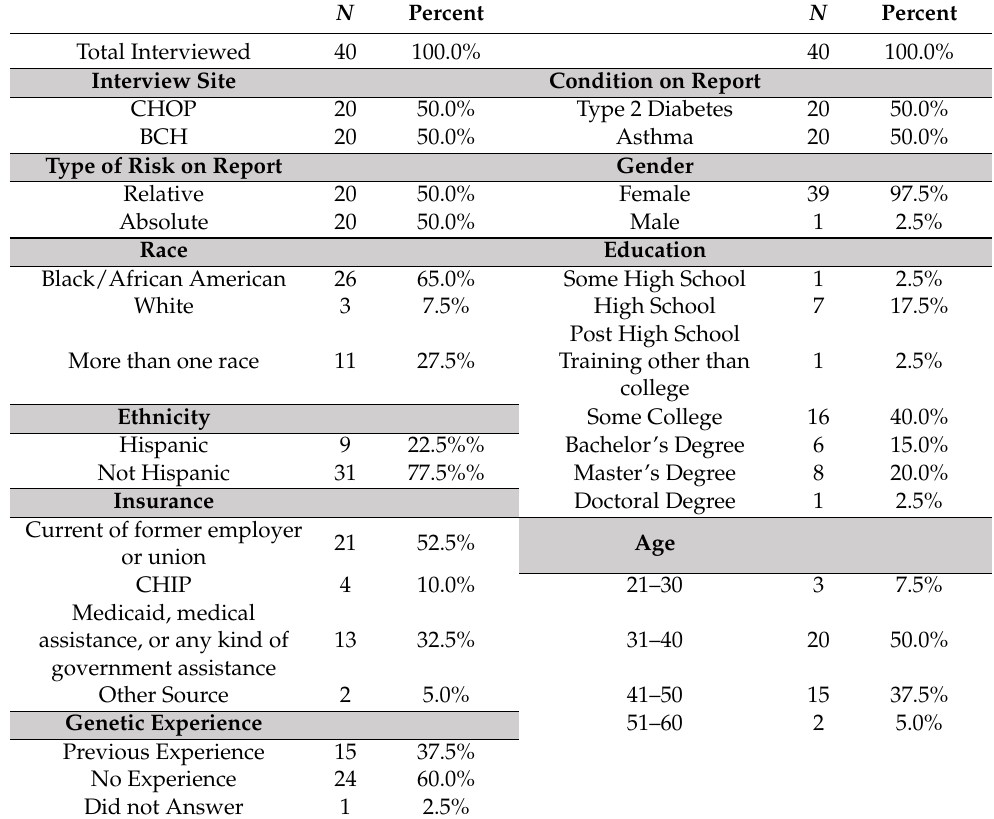
Table 1. Interviewee Demographics.